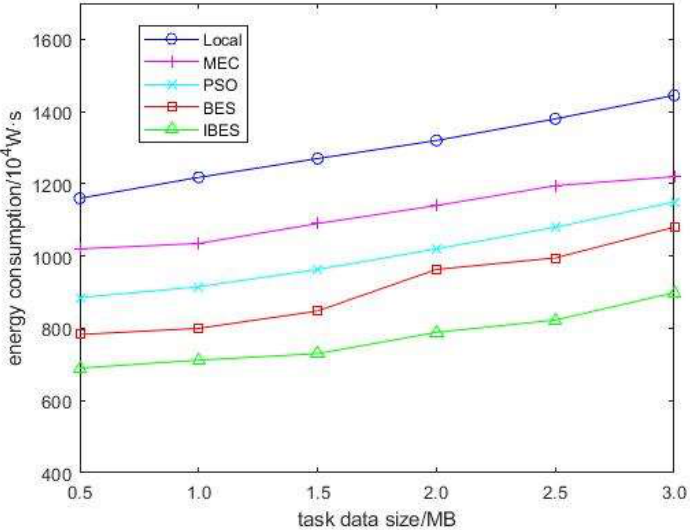
Figure 5. Comparison of energy consumption under different task data size.